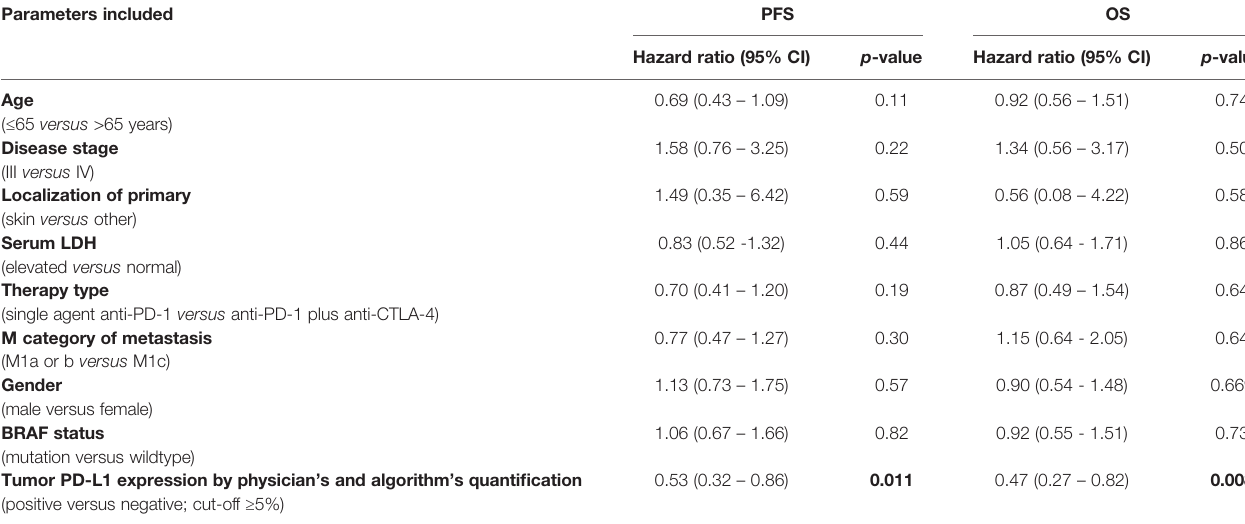
Multivariable Cox regression of the combined PD-L1 analysis by physician and digital algorithm including clinical and molecular parameters determined at the start of anti-PD-1 therapy in n=156